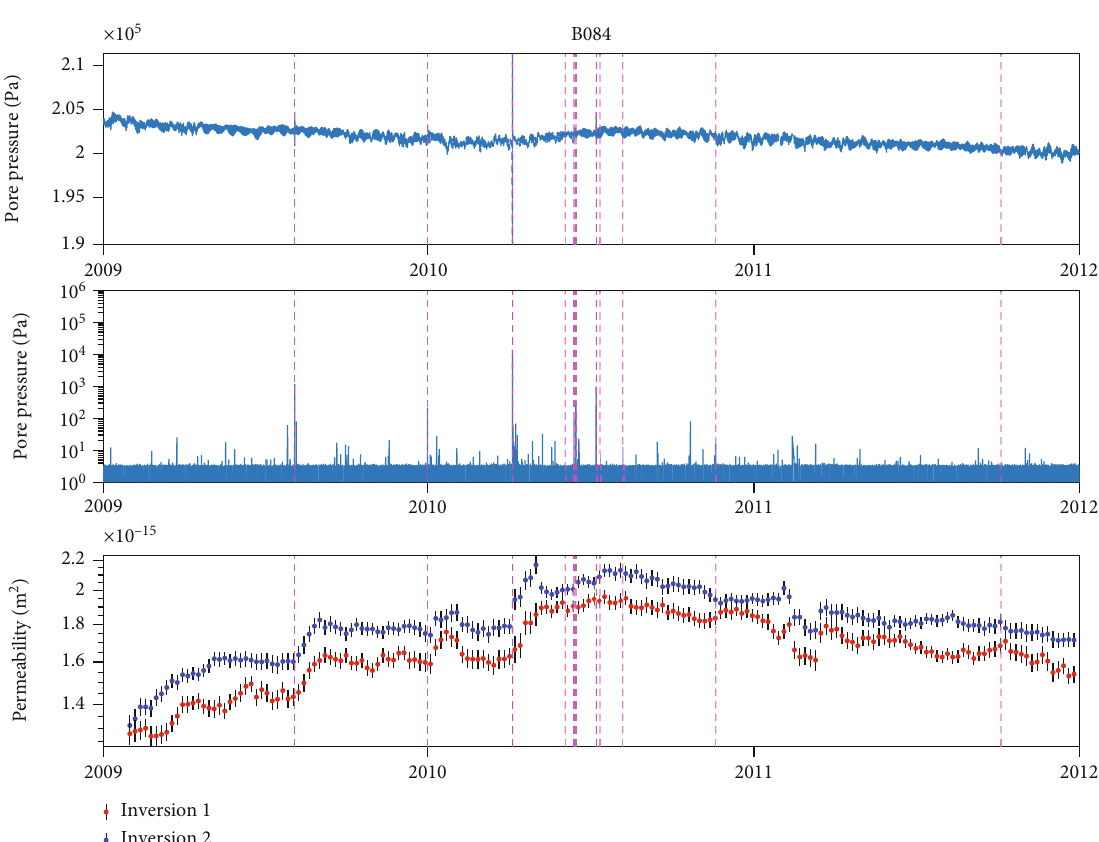
Figure 11: Raw borehole pore pressure, high-pass fi ltered borehole pore pressure, and permeability plotted to look for changes in permeability caused by earthquakes. Earthquakes with a seismic energy density above 10 -3 J m -3 are plotted as magenta dashed lines. Inversion 1 uses fi ltered borehole pore pressure and fi ltered modeled strain for analysis. Inversion 2 uses fi ltered borehole pore pressure and fi ltered strainmeter data for